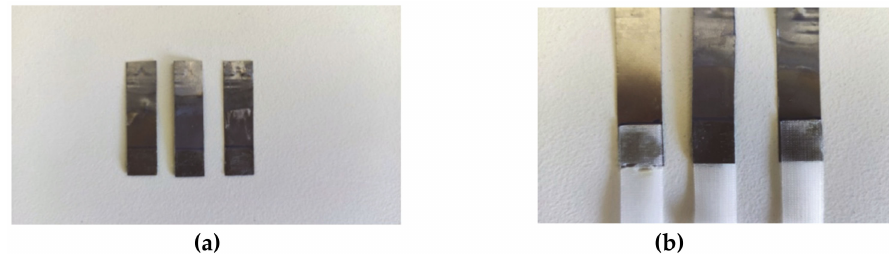
Figure 1. ( a ) Anodized titanium adherends and ( b ) Single lap joints made of poly-lactic acid (PLA) scaffolds and anodized titanium